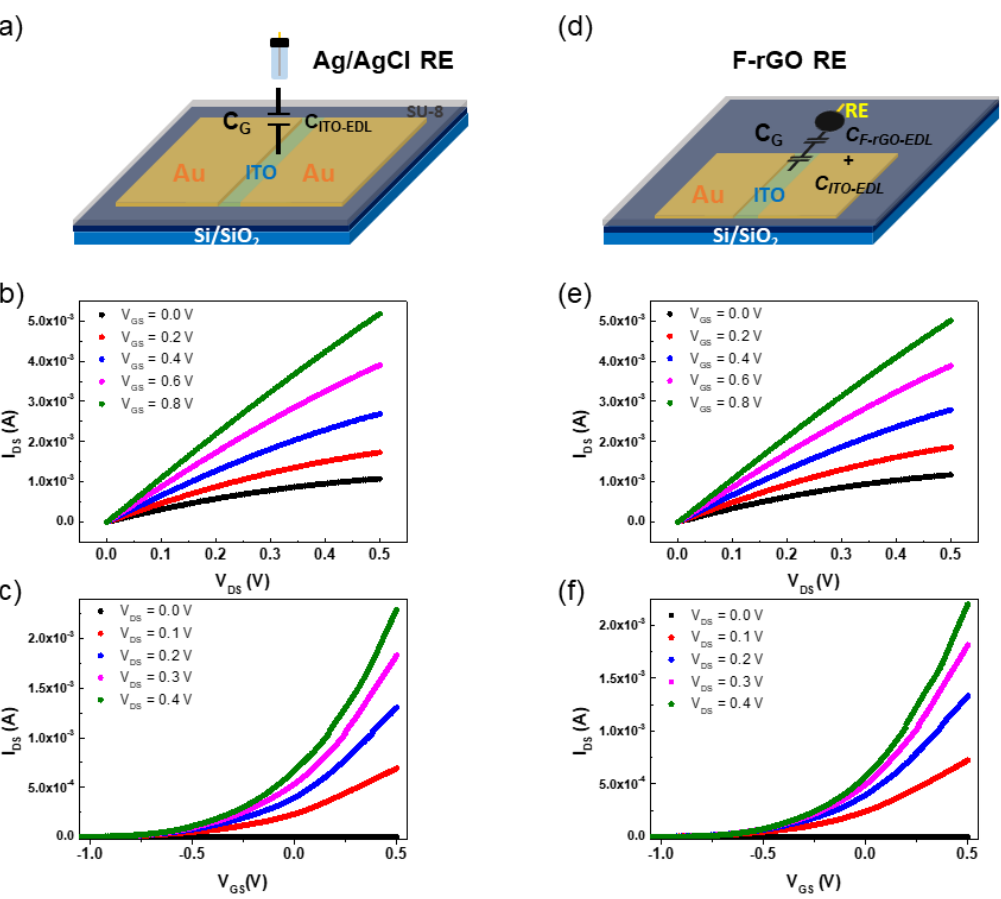
Figure 3. ( a ) Schematic diagram of the Ag/AgCl RE. ( b ) I DS − V DS and ( c ) I DS − V GS transfer characteristics of ITO − ISFET with the Ag/AgCl RE. ( d ) Schematic diagram of F − rGO RE. ( e ) I DS − V DS and ( f ) I DS − V GS transfer characteristics of the ITO ‐ ISFET with the F − rGO RE.